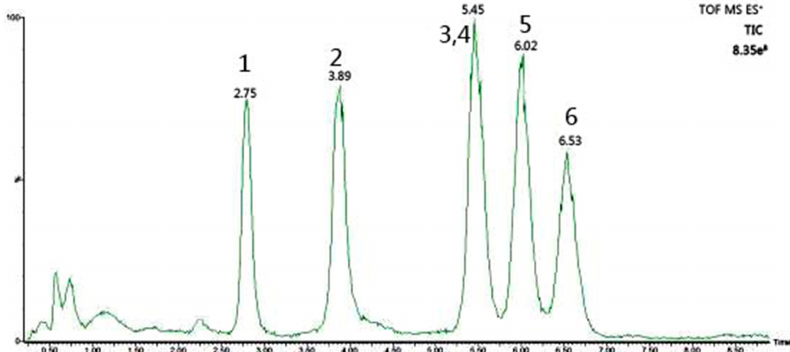
Figure 1. The total ion chromatograms of standard monosaccharides in positive ion mode (1: mannose,